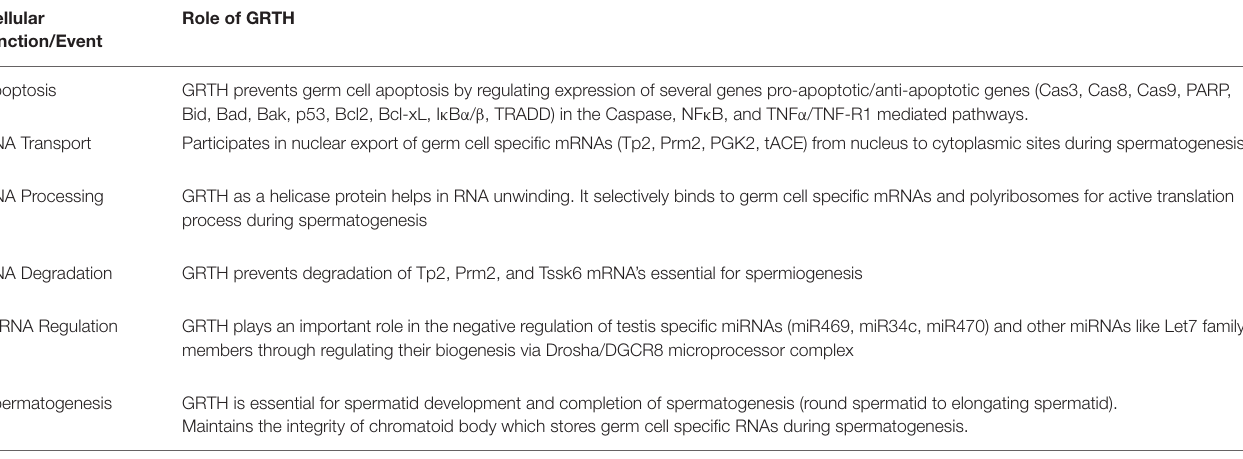
TABLE 1 | Summary - GRTH, a multi-functional protein regulating several cellular events. Cellular